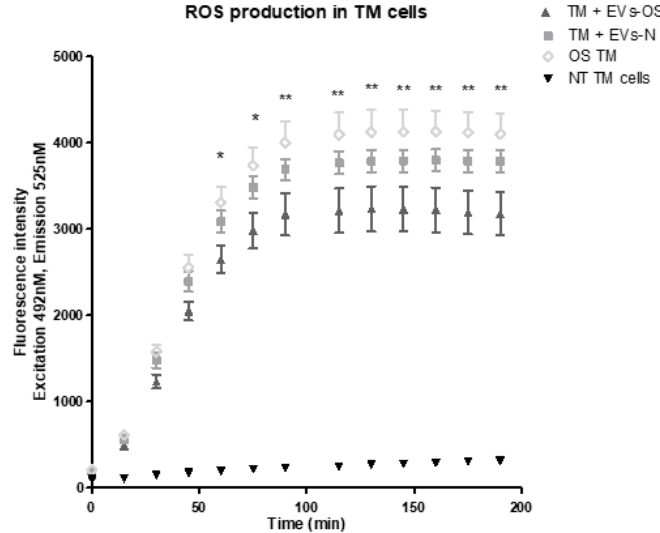
Figure 8. Kinetic estimation of AAPH-induced ROS generation in TM cells following incubation with normal or stressed NPCE EVs. TM cells were pretreated with normal or stressed NPCE exosomes for 24 h, and then rinsed with P hosphate buffer saline . Subsequently, the pretreated cells were incubated with DCFDA (2 ′ ,7 ′ -dichlorofluorescin diacetate) for another 1 h at 37 °C. This was followed by the washing step and addition of either PBS or AAPH (150 µM). ROS amounts in TM cells were quantified with or without NPCE exosomes pretreatments and results are presented as mean fluorescence intensity ± SEM from three independent experiments. Fluorescence was determined at 15 min intervals over a period of 3 h. The asterisks indicate significant differences between the untreated TM cells and TM treated with NPCE stressed EVs. * p < 0.05, ** p < 0.01, in one-way ANOVA with post hoc Tukey’s test.